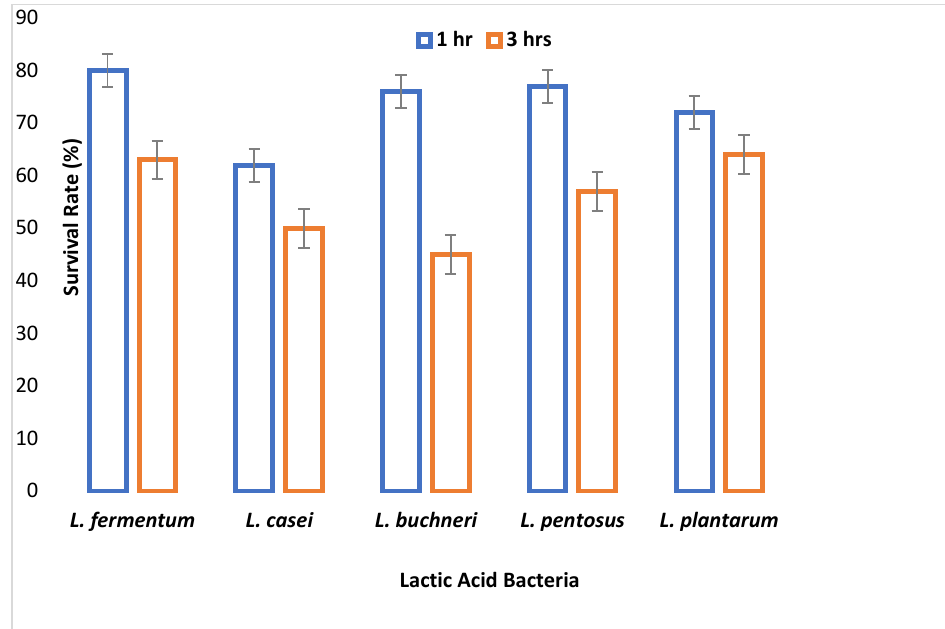
Figure 3. Survival of lactic acid bacteria isolates at pH 3.0 after 1 and 3 h, respectively. L. fermentum was well adapted to pH 3.0 far more than the other LAB isolates. The percentage of LAB isolates that survived different concentrations of bile salt (0.3%, 0.5%, and 1%) ranged from 40.7% to 93.3%. The percentage of L. casei that sur- vived 0.3%, 0.5%, and 1% bile salt concentrations after 4 h were 59.3%, 50%, and